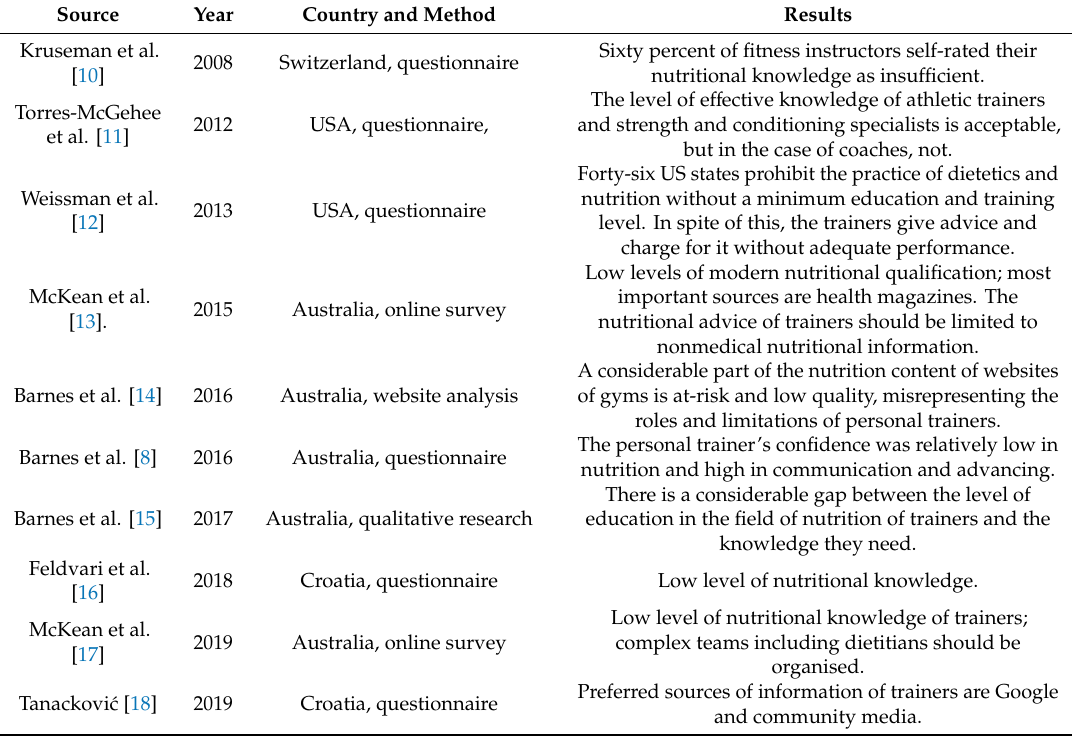
Table 1. Low level of nutritional knowledge is a general problem of the fitness industry—some examples from the